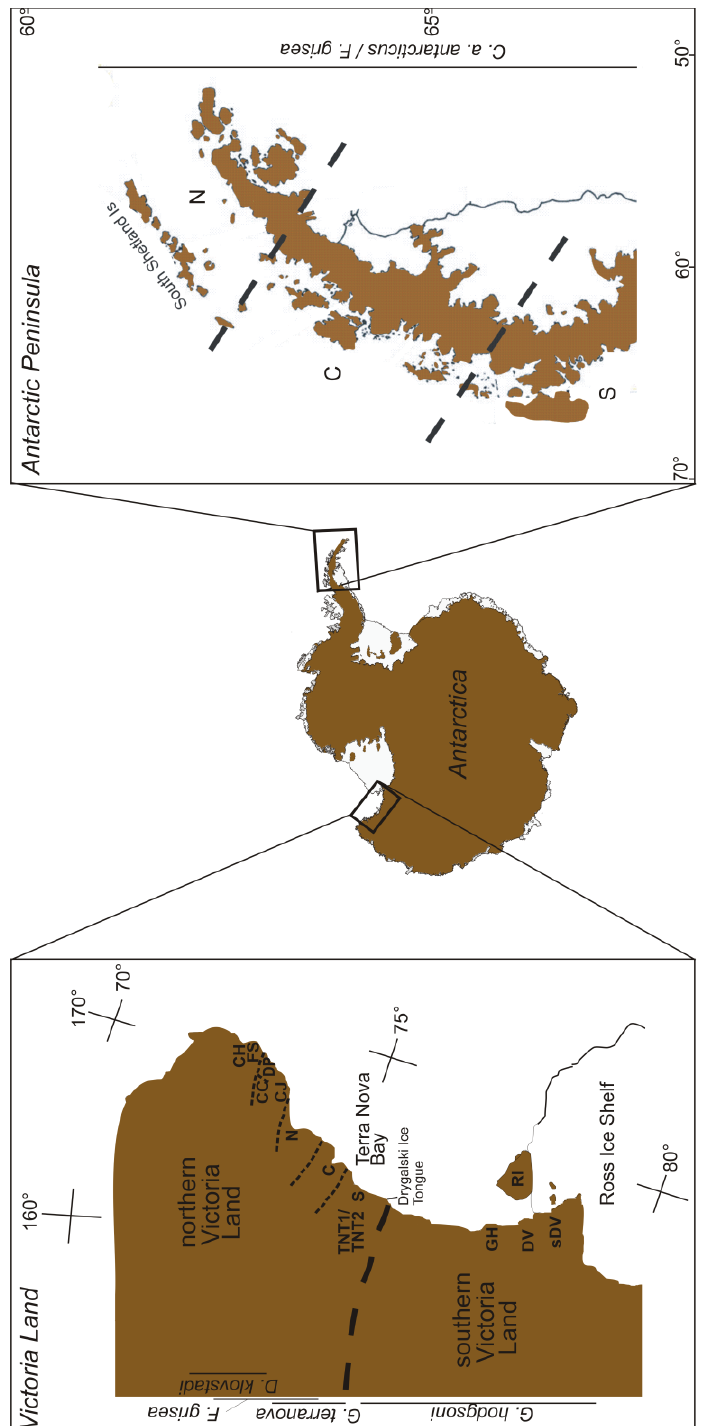
Figure 2. Figure showing the phylogeographic sampling that has been achieved for four Antarctic springtail species across their distributional ranges (as indicated by vertical lines beneath/above species names). The codes used in the two inset boxes are location codes and refer to potential refugial locations for each species as referred to in the respective publications and Table 1. Dashed line in the inset boxes indicate heavy or fine biogeographic breaks among regions and in many cases also represent major glacial systems. See text for further